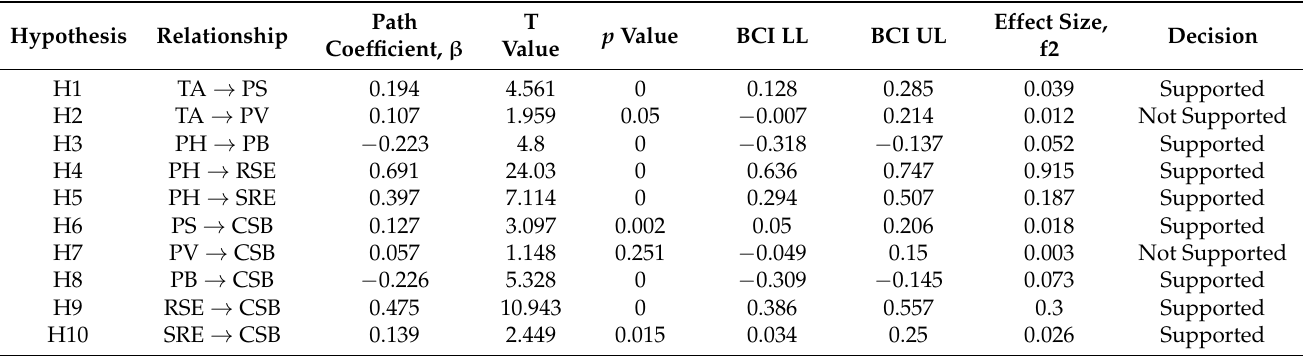
Table 5. Summary of the structural